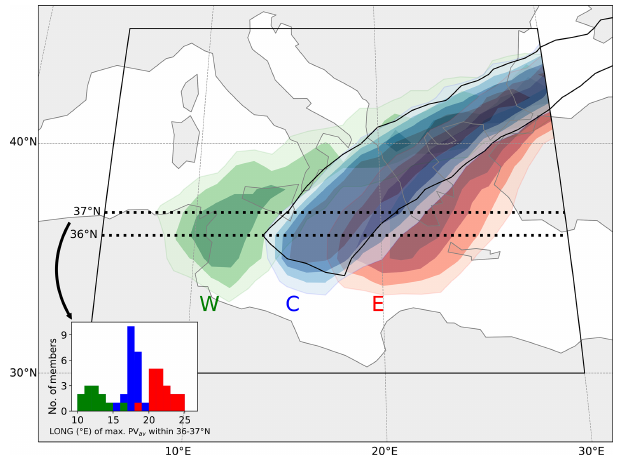
Figure 7. Clustering of ensemble members (initialized at 00:00UTC 24 September 2018) according to the position of the upper-level PV streamer in the Mediterranean at 00:00UTC 27 September 2018. Colors show frequencies of PV av ≥ 2PVU (shading, every 20%) for each cluster (blue: cluster C, green: clus- ter W, red: cluster E), and the black line shows the contour where PV av = 2PVU in the operational analysis. The region considered for the clustering is shown by the black box. PV av denotes verti- cally averaged PV between 320 and 330K with PV values below 2PVU set to zero (see text for